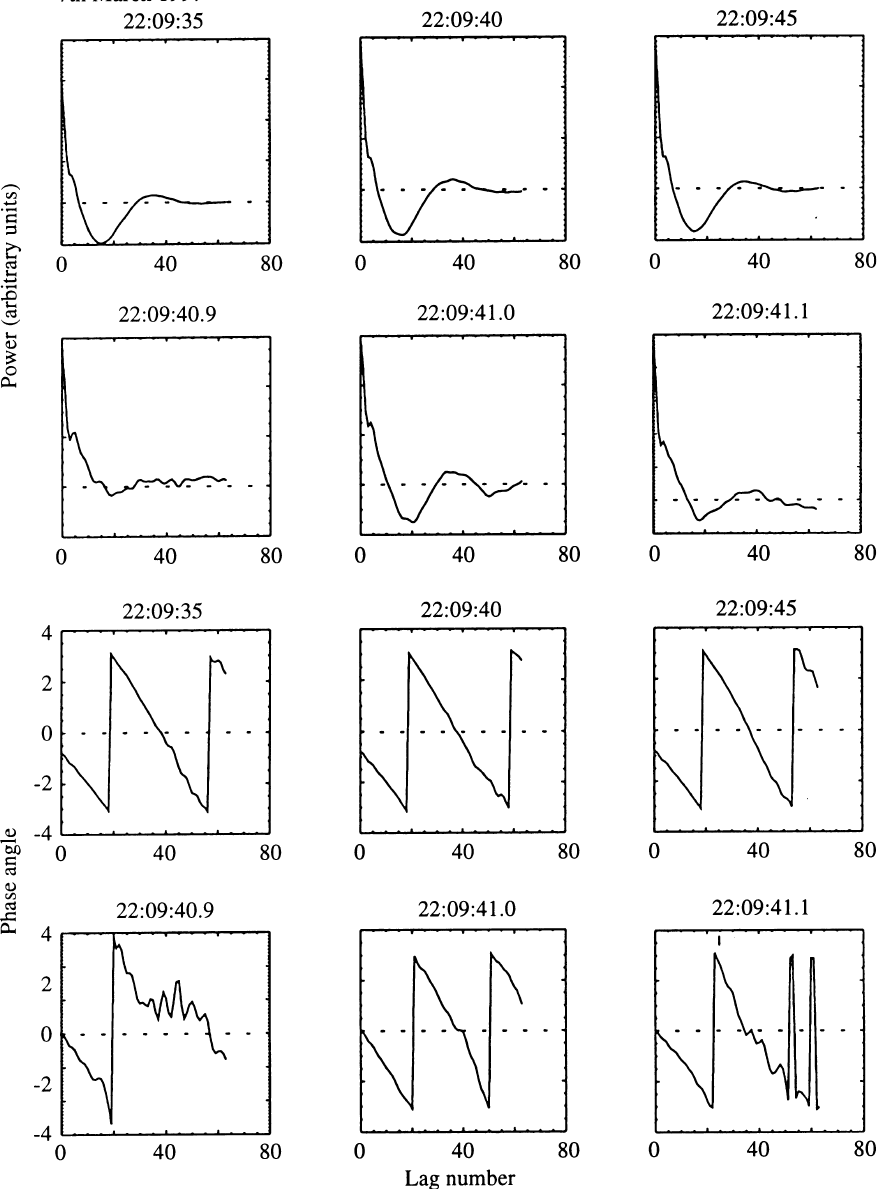
Fig. 6. A comparison of low (1st and 3rd row) and high (2nd and 4th row) time resolution ACFs and the phase angles calculated from